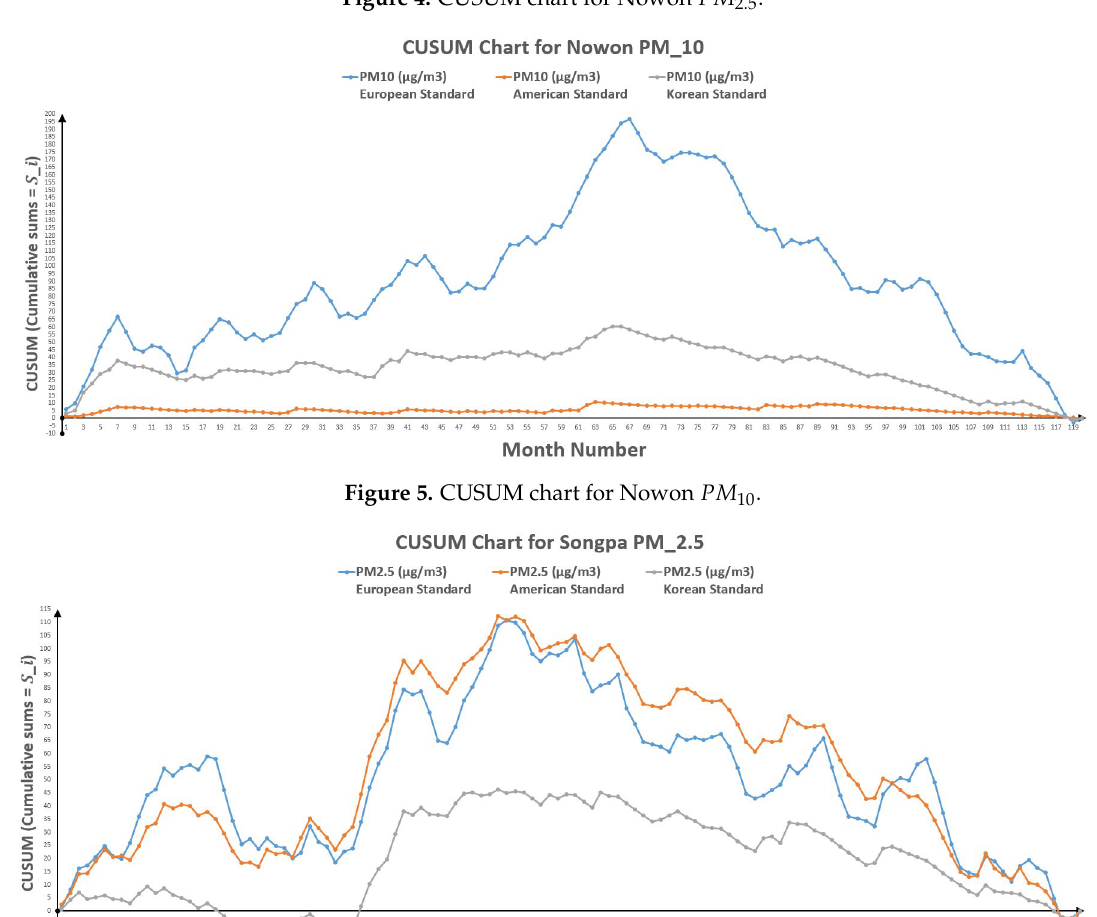
Figure 4. CUSUM chart for Nowon PM 2.5 .